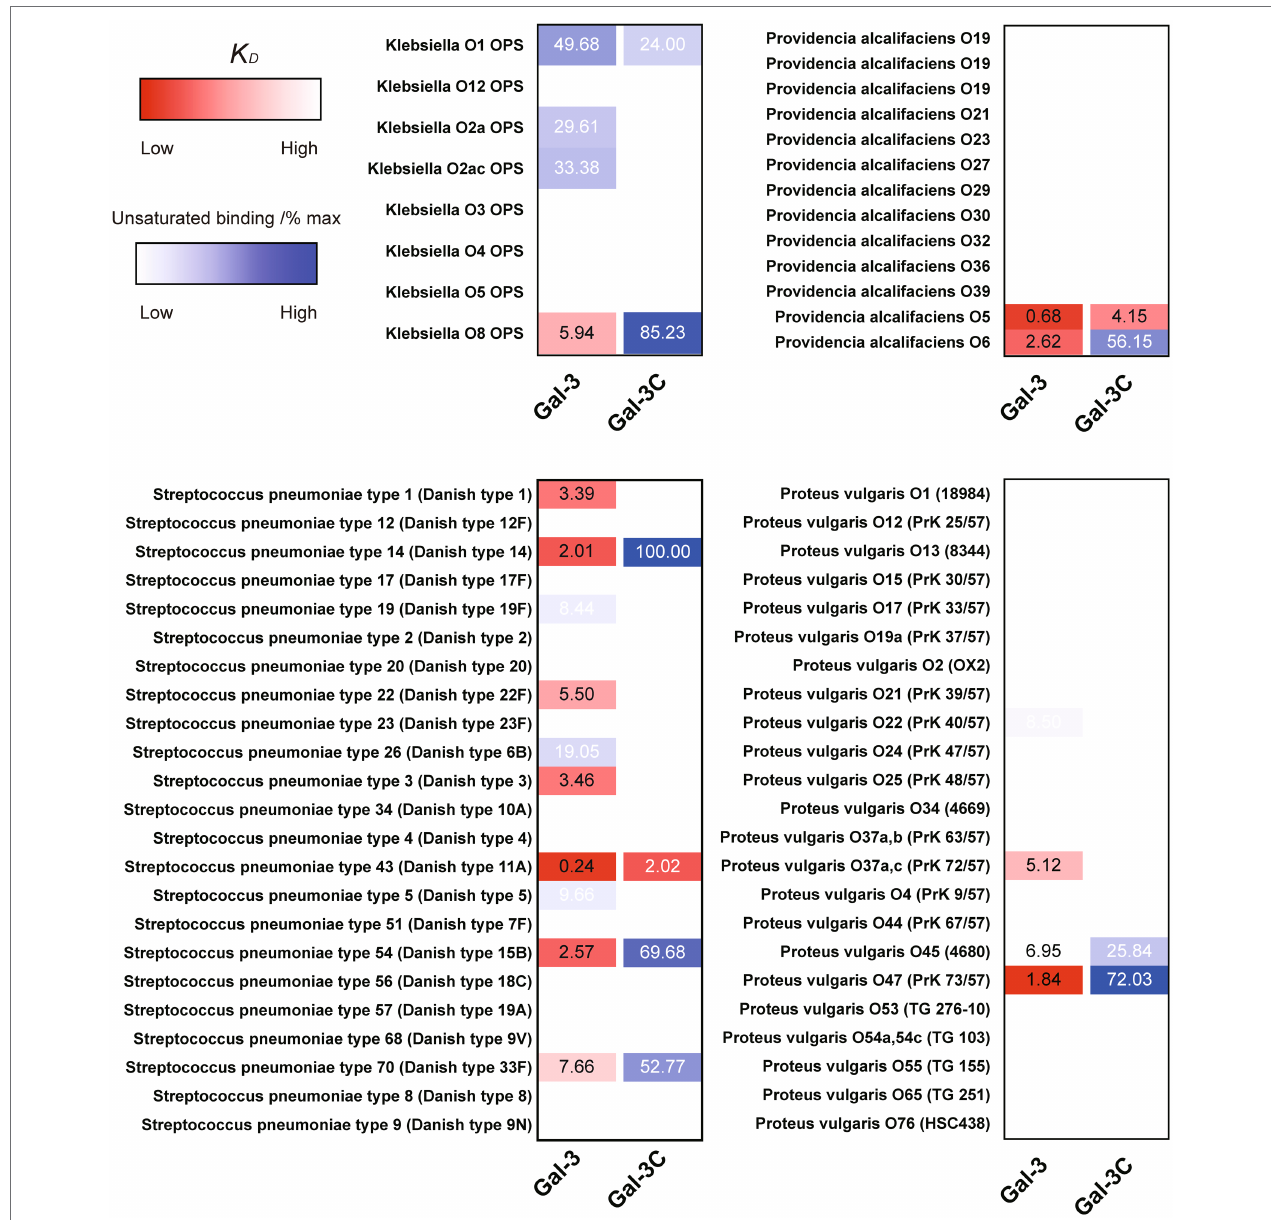
FIGURE 6 | KD values of Gal-3 and Gal-3C binding to microbial glycans. Selected bacteria are presented along with heat map representation of KD and unsaturated binding (% max). The KD and % max values were sorted by red and blue color, respectively. The heat map from darker red (low KD ) to light red (high KD ). For the unsaturated binding, the heat map from light blue (low % max) to darker blue (high %